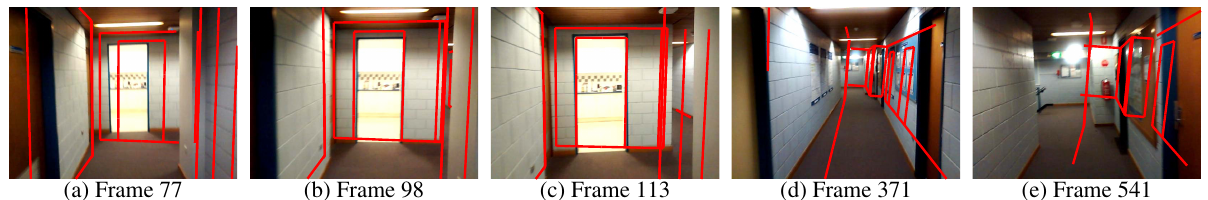
Figure 9. Predicted camera poses by a network fine-tuned with Gradmag-Syn-car dataset and tested with edge gradmag of real images. Frame